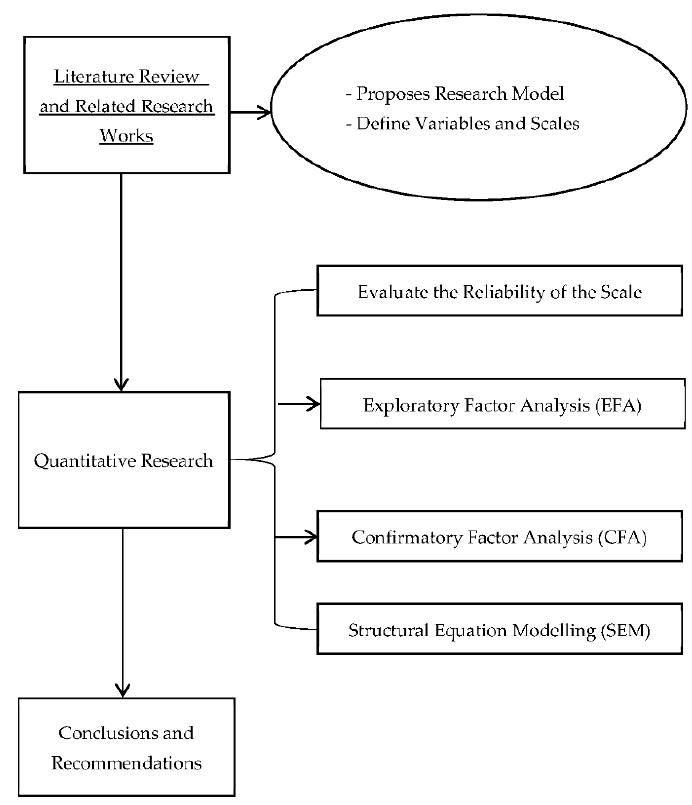
Figure 2. Proposed research structure.